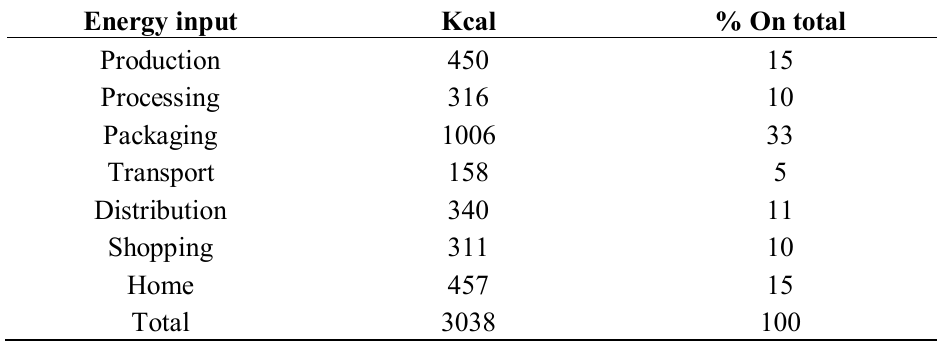
Table 1. Energy input for a 455 g, can of sweet corn in the USA market (from [3]